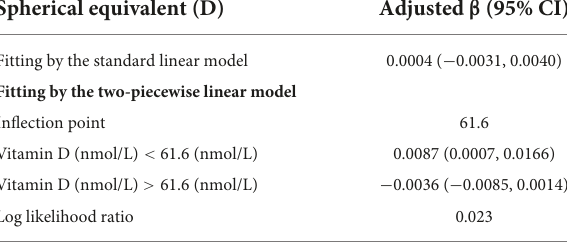
TABLE 3 Threshold effect analysis of vitamin d on spherical equivalent using the two piecewise linear regression model.